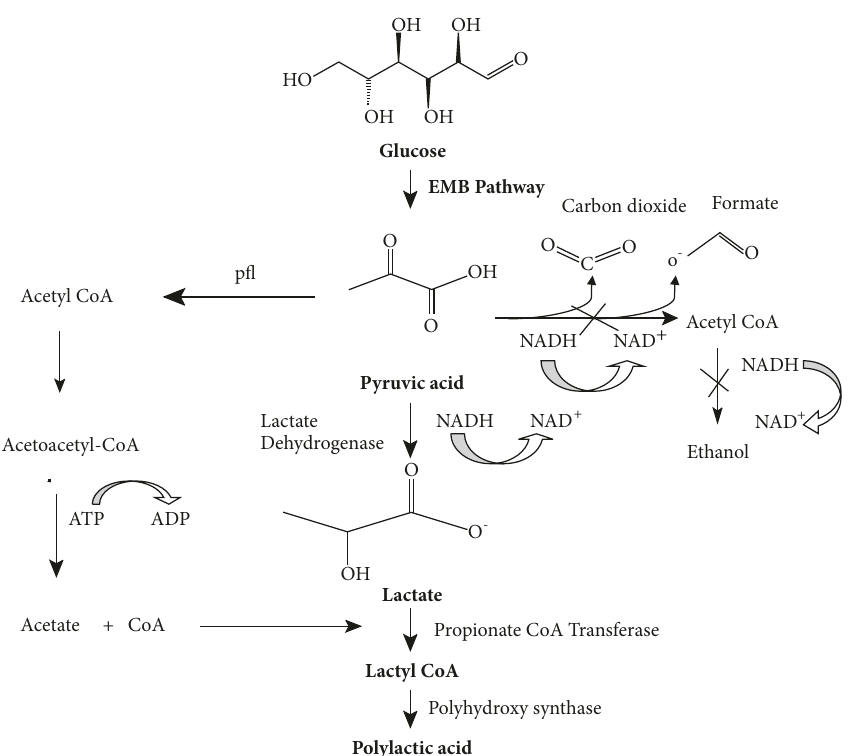
Figure 5: A schematic presentation of production of polylactic acid by metabolic